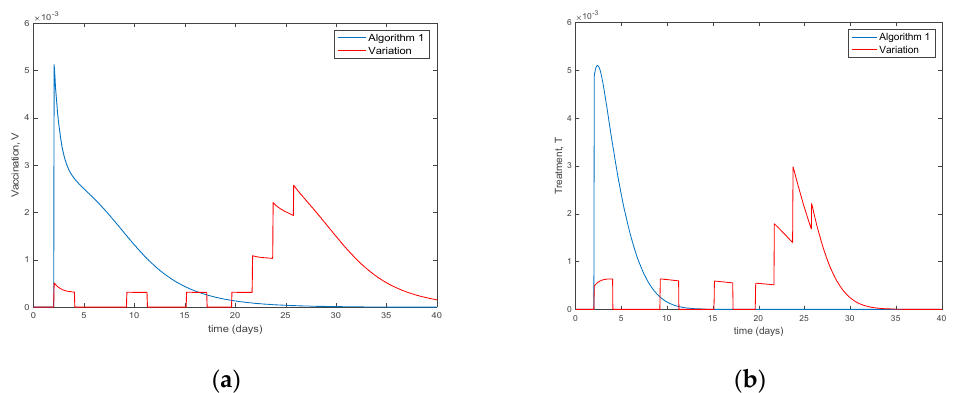
Figure 5. Comparison in the control efforts between Algorithm 1 and its proposed variation. ( a )